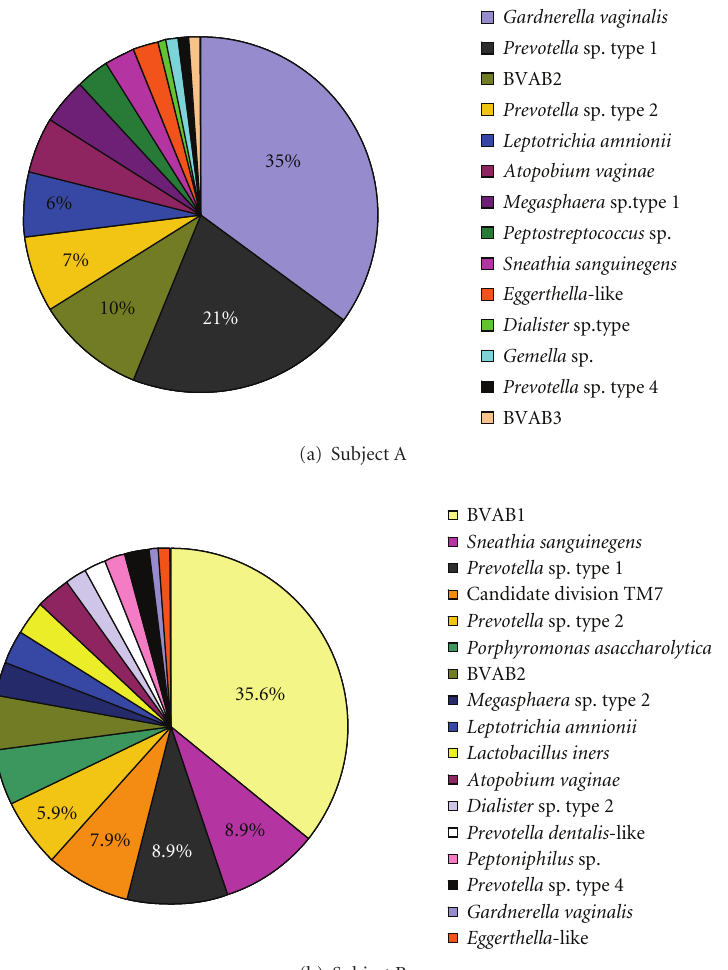
Figure 3: The microbiology of BV is heterogeneous. Comparison of rank abundance plots from 2 subjects diagnosed with BV. The charts show the percentages of clones in each library corresponding to specific bacterial 16S rRNA gene sequences obtained using broad range PCR followed by cloning and sequencing. The most prevalent bacterial clones in Subject A include those matching Gardnerella vaginalis , Prevotella sp. type 1, BVAB2, Prevotella sp. type 2, and Leptotrichia amnionii . In contrast, the most prevalent clones in Subject B